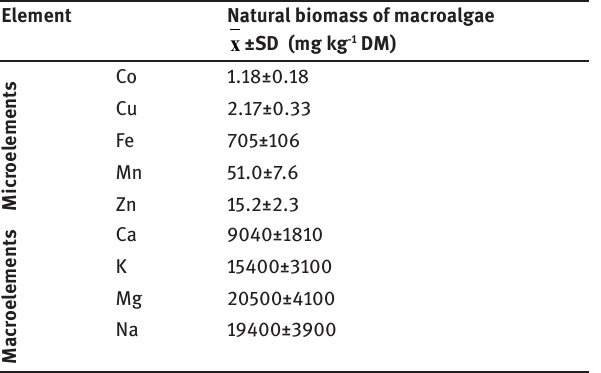
Table 3: The mineral composition of natural biomass of macroalgae. Element